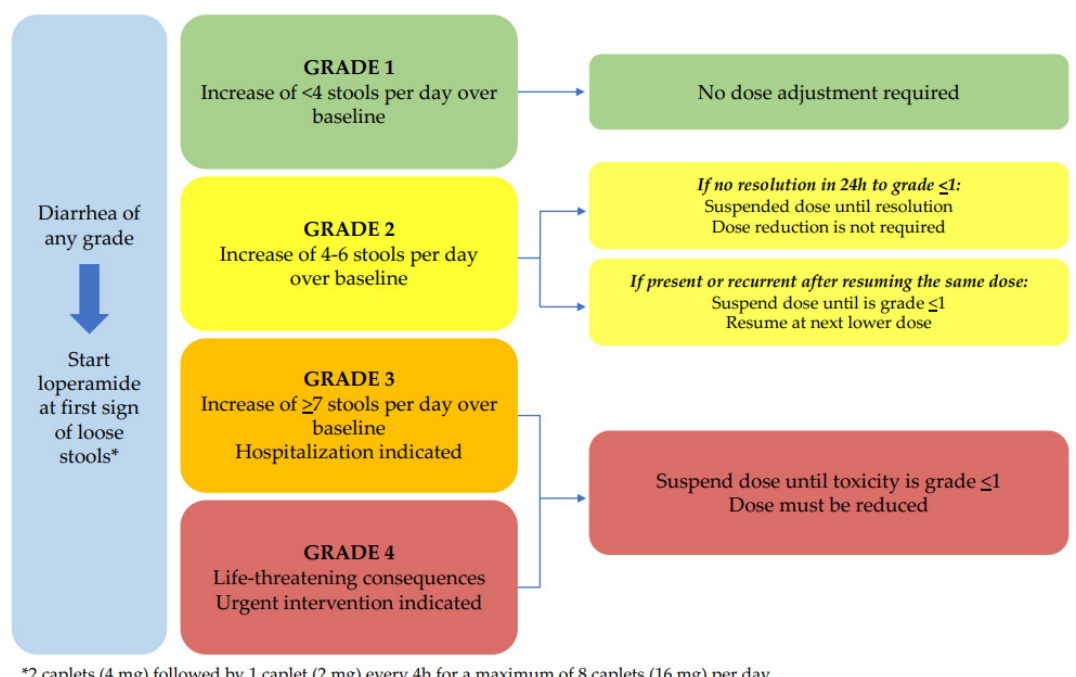
Figure 4. Simplified representation of management recommendations for diarrhea induced by abemaciclib, based on the European Medicines Agency (EMA) recommendations [32]. Toxicity grade is defined according to the Common Terminology Criteria for Adverse Events (CTCAE) v5.0.